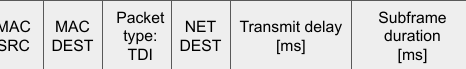
Figure 7. TDI packet